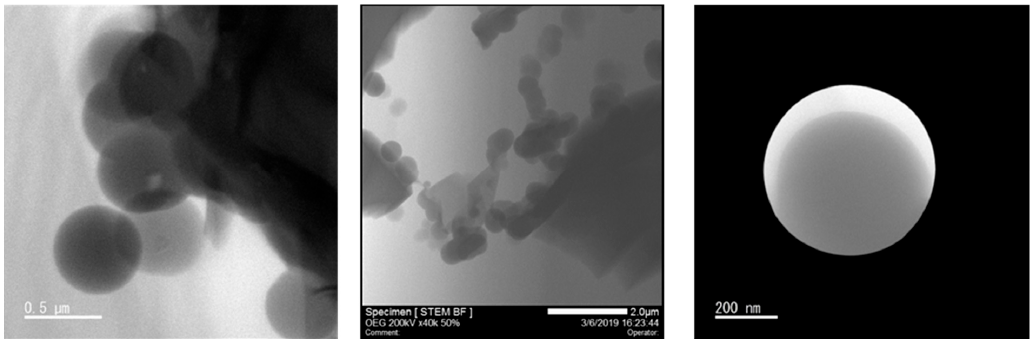
Figure 11. The TEM and STEM analysis of the obtained products.